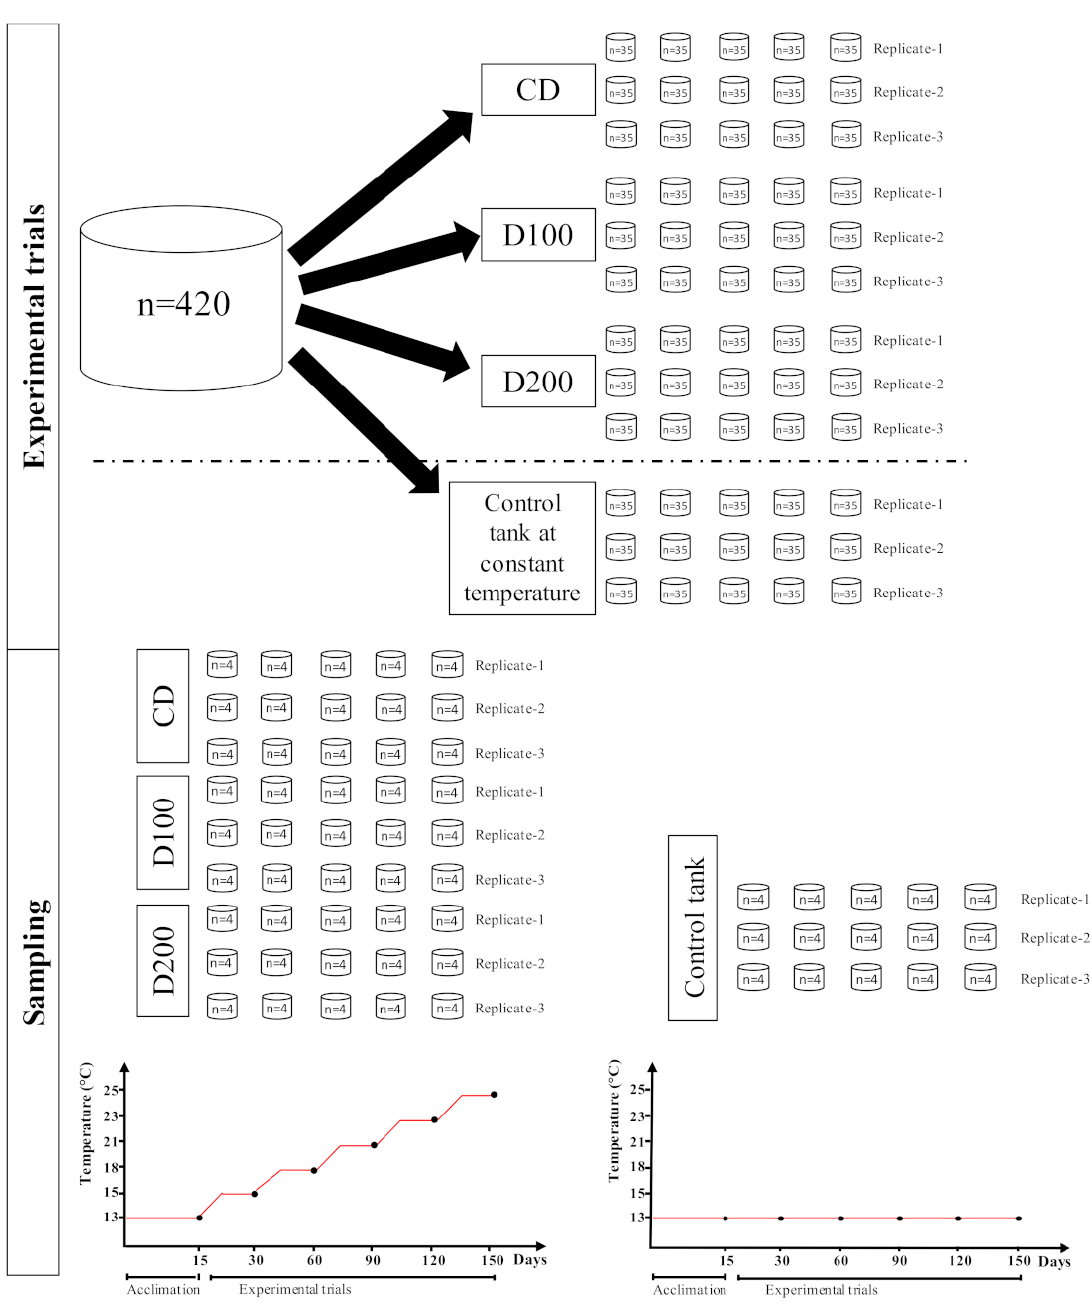
Figure 1. Schematic design of experimental trials and sampling